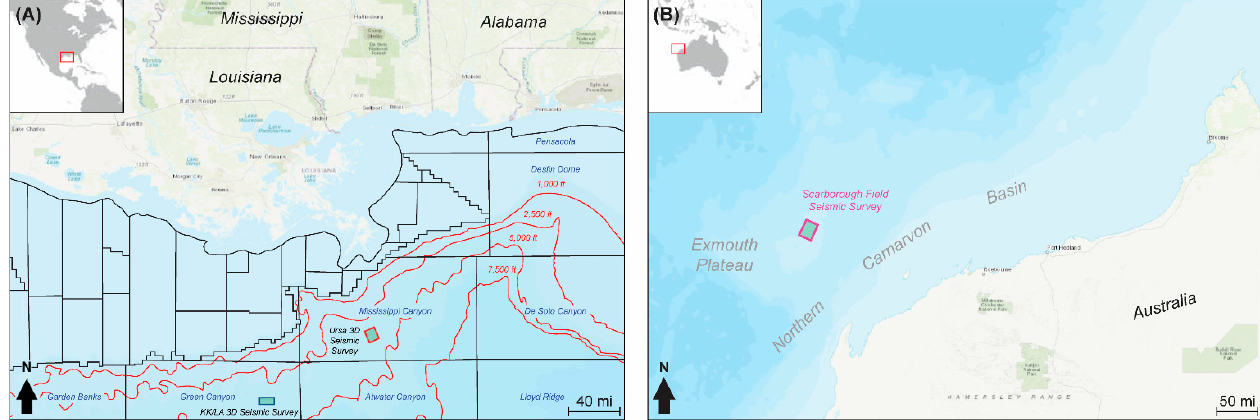
Figure 2. Location of the 3D seismic surveys used in this study. Two of these datasets are located in ( A ) offshore Gulf of Mexico, while the other dataset is located in ( B ) offshore Australia within the Northern Carnarvon Basin. Gulf of Mexico protraction grid and seafloor outlines taken from the BOEM.